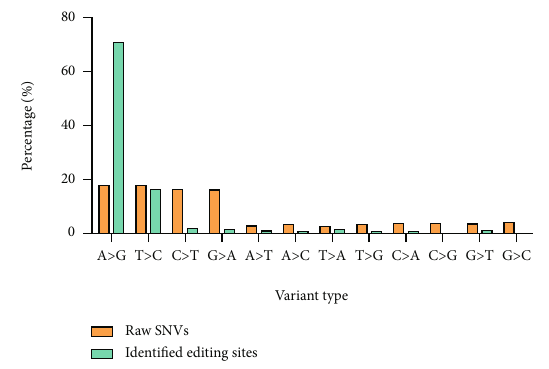
Figure 3: Percentage of all twelve mismatch